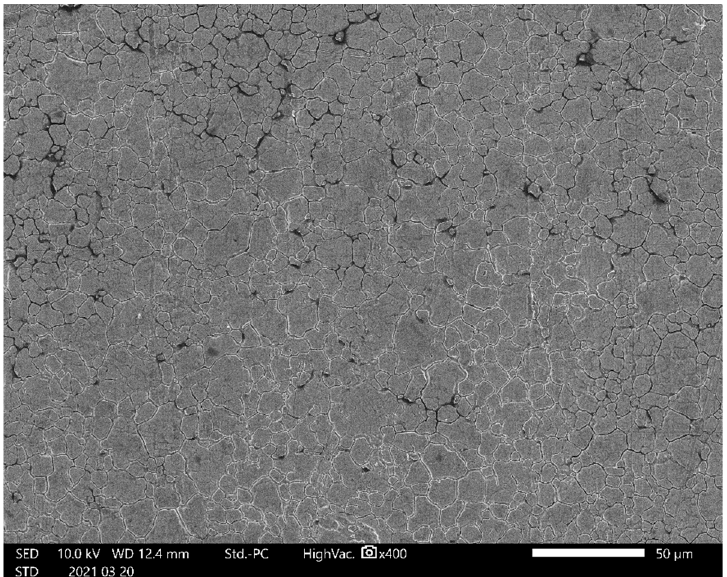
Figure 7. Aspect of the surface of specimen A observed by scanning electron microscope (SEM).